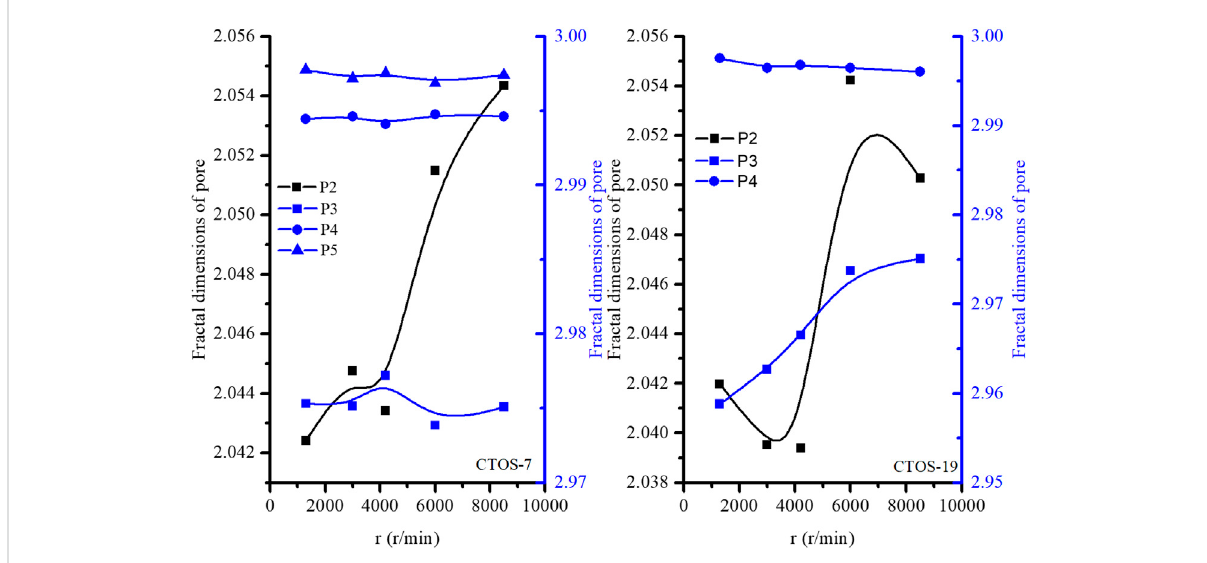
FIGURE 9 The difference change of pore fractal dimension for various pores in CTOS-7 and CTOS-19 samples.